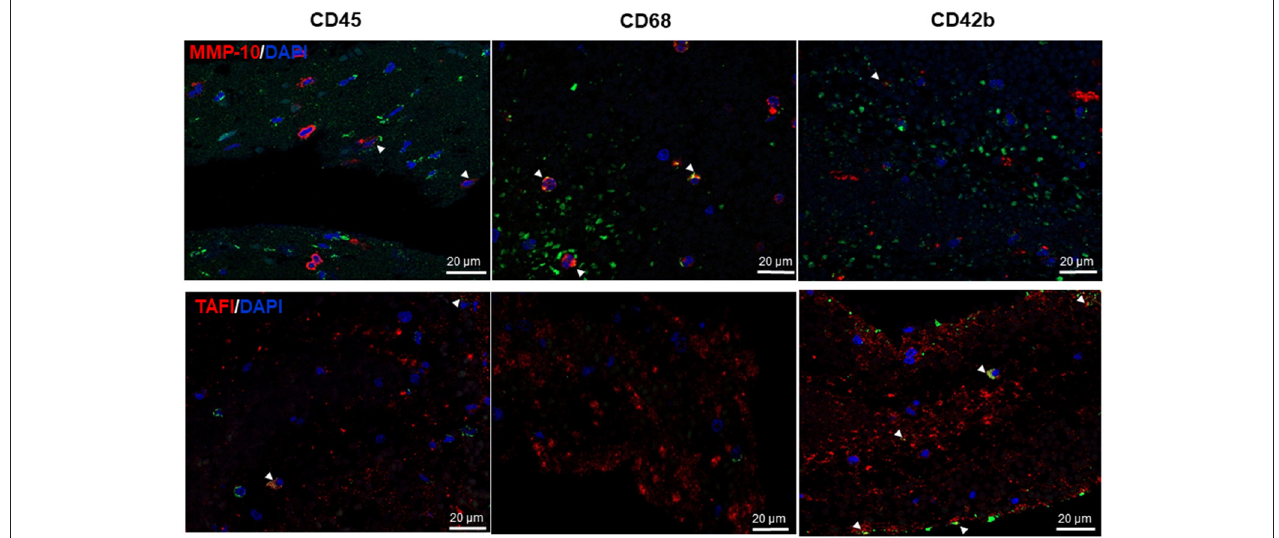
FIGURE 3 | Matrix metalloproteinase-10 (MMP-10) and thrombin-activatable fibrinolysis inhibitor (TAFI) colocalize with inflammatory cells and platelets in thrombi. Double immunofluorescence for MMP-10 (top, red) and TAFI (bottom, red) and leukocytes (CD45, left), macrophages CD68 (middle), and platelets CD42b (right, green); cell nuclei are stained with 4 ′ ,6-diamidino-2-phenylindole (DAPI) (blue). Arrow heads point to double positive cells for MMP-10 (upper panels) and TAFI (lower panels) and the specified antigens (yellow). Scale = 20 µ m.